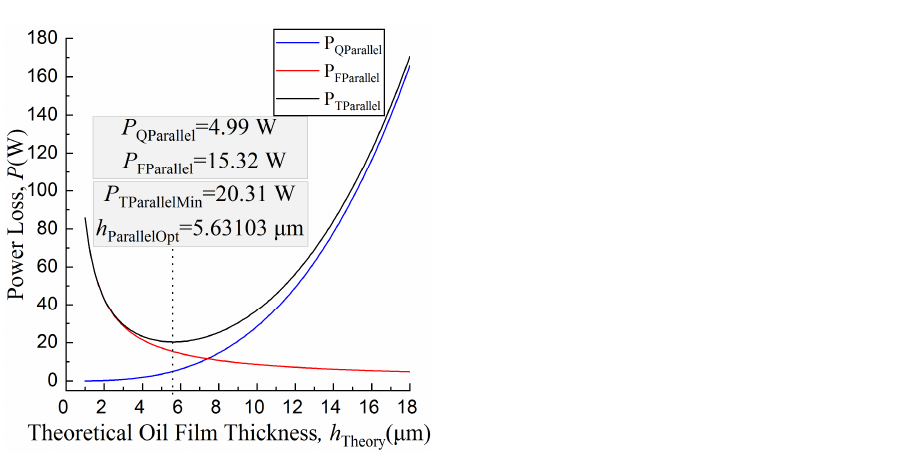
Figure 14. Influence of parallel oil film thickness on leakage, friction, and total power loss.